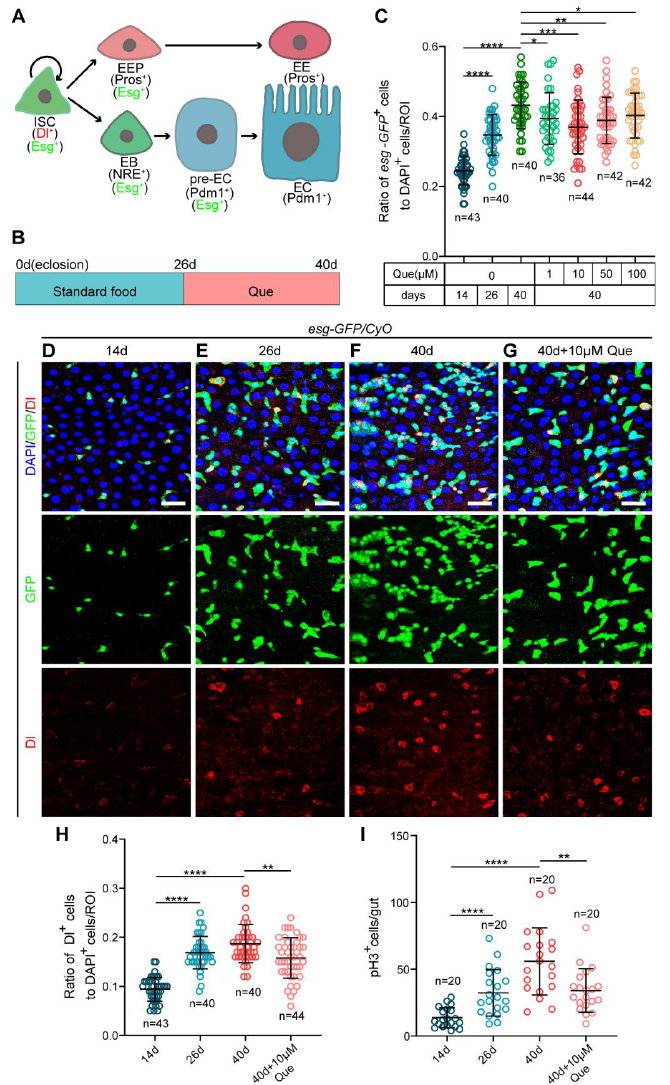
Figure 1. Que prevents gut hyperplasia in aged Drosophila . ( A ) The Drosophila intestinal stem cell (ISC) lineages. ISCs (marked by Dl and Esg) divide asymmetrically to renew themselves and give rise to enteroendocrine progenitor cells (EEPs; marked by Esg and Pros) or enteroblasts (EBs; marked by Esg and NRE). EEPs further differentiate into enteroendocrine cells (EEs; marked by Pros), whereas EBs with high Notch signaling (pre-ECs; marked by Esg and Pdm1) further differentiate into enterocytes (ECs; marked by Pdm1). ( B ) Schematic diagram showing the process of feeding quercetin (Que) to Drosophila . ( C ) The ratio of esg-GFP + cells to DAPI + cells per region of interest (ROI) in the posterior midguts of 14-, 26-, and 40-day-old flies ( esg-GFP/CyO ) without Que supplementation and 40-day-old flies fed with four concentrations (1, 10, 50, and 100 µ M) of Que. n: number of ROI counted. ( D – G ) Representative immunofluorescence images of 14- ( D ), 26- ( E ), and 40-day-old ( F ) posterior midguts without Que supplementation and 40-day-old posterior midguts with 10 µ M Que supplementation ( G ) stained with DAPI (blue; nuclei), GFP (green; ISCs and progenitor cells marker), and Dl (red; ISCs marker). The top panels represent the merged images, the middle panels represent esg-GFP , and the bottom panels represent Dl. Scale bars represent 25 µ m. ( H ) The ratio of Dl + cells to DAPI + cells per ROI in the posterior midguts of flies in experiments D-G. n: number of ROI counted. ( I ) The number of pH3 + cells in the whole guts of flies in experiments D-G. n: number of guts counted. Error bars represent standard deviation (SDs). Student’s t -tests, * p < 0.05, ** p < 0.01, *** p < 0.001, and **** p <